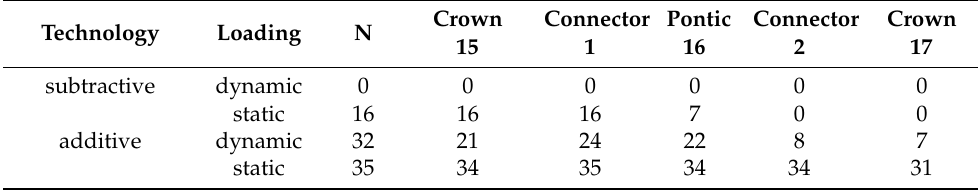
Table 2. Areas of failures during dynamic and static loading of